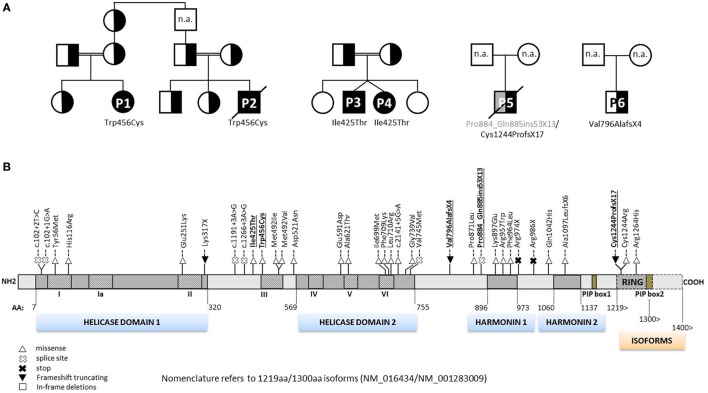
Pedigrees of RTEL1-deficient patients and annotation of mutations. (A) Six RTEL1-deficient patients with their respective nuclear families are shown. P1 and P2 are part of a large consanguineous pedigree. P3 and P4 are twins. Heterozygous family carriers are indicated by half-filled symbols. P1–P4 carry homozygous missense mutations, P5 and P6 carry biallelic and monoallelic nonsense mutations, respectively. n.a., not analyzed. (B) The 1300aa RTEL1 isoform protein structure displaying the novel mutations described in this study (highlighted in bold, underlined font) along with previously reported mutations. Mutations previously reported using 1243aa isoform (NM_032957) in three reports (9, 10, 20) have been adapted to 1300aa isoform (NM_001283009). Heterozygous missense variants identified in association with pulmonary fibrosis (21–23) are not shown. For clarity, mutations are shown on protein level without “p.” as preceding.